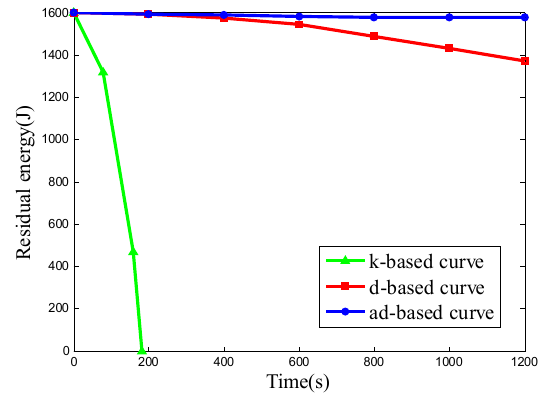
Figure 17. The residual energy of the network in node deployment (c): C 1 is deployed with 50 nodes, C 2 is deployed with 150 nodes, C 3 and C 4 are deployed with 300 nodes.